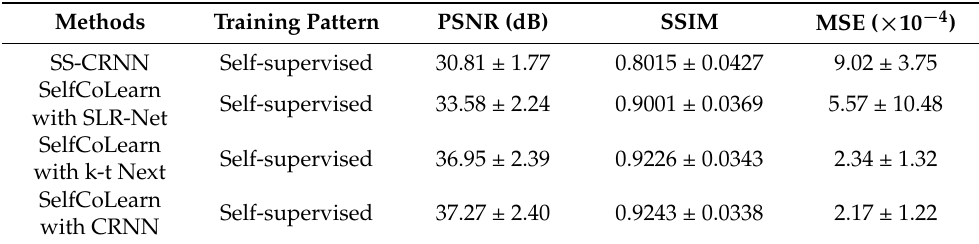
Table 3. Quantitative results of SS-CRNN and SelfCoLearn with different backbone networks at 8-fold acceleration (mean ±